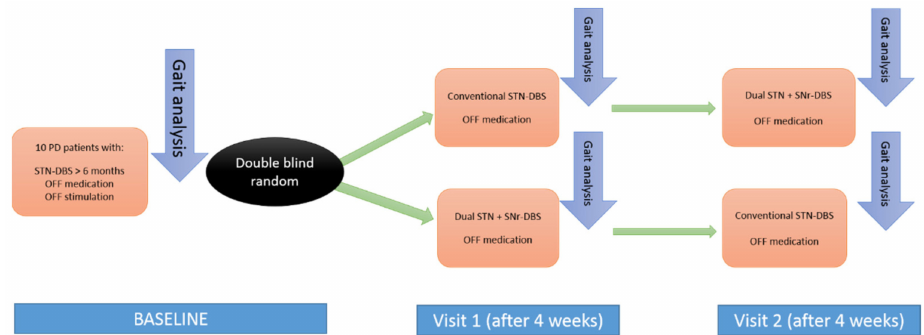
Figure 1. Representation of the protocol via block diagram. PD: Parkinson’s disease. STN-DBS: Subtha- lamic deep brain stimulation. STN + SNr-DBS: Dual subthalamic and nigral deep brain